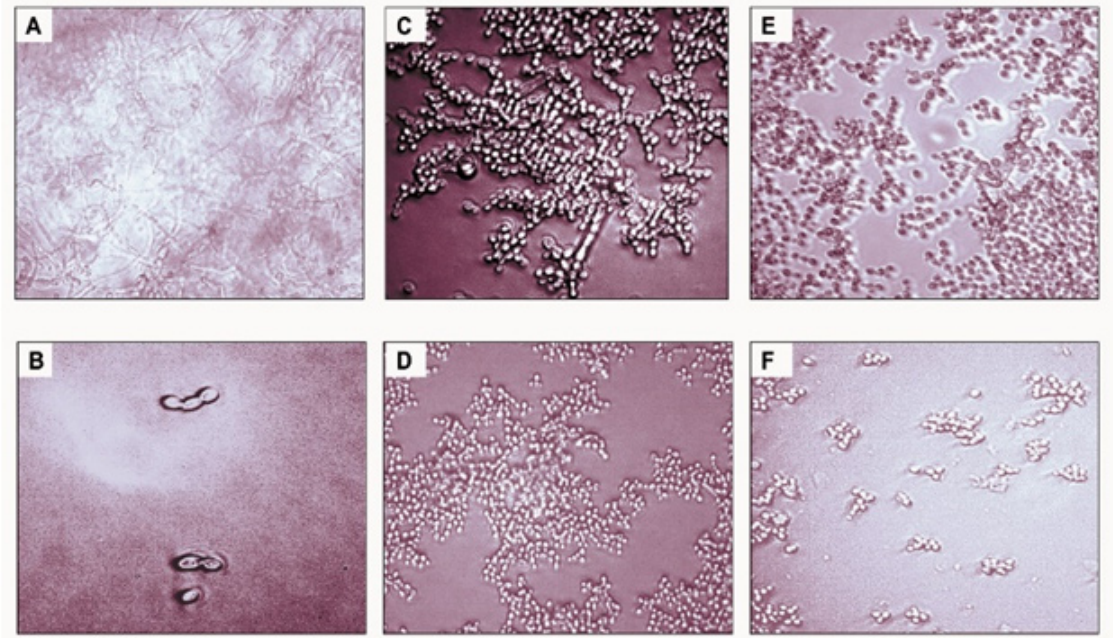
Figure 5. Light microscopy photomicrograph illustrating the different morphology of C. albicans with and without precoating aptamer (Ca-apt1) and grown for 48-h in the growth medium supplemented with cigarette smoke condensate (CSC). The pictures show biofilm of C. albicans derived from clinical isolate, without either precoating aptamer or added CSC ( A ), C. albicans with precoated aptamer but untreated with either CSC/ CCSC or NCSC ( B ), C. albicans precoated with 1 ng/µL aptamer, CCSC ( C ) and NCSC ( E ), and 10% aptamer with CCSC ( D ) and NCSC ( F ). All microscopic image show at X 200